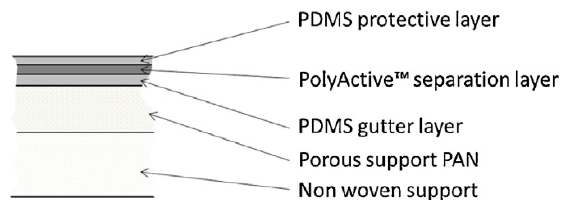
Figure 1. Schematic representation of the cross-sectional structure of the multilayer thin film composite membrane [11].